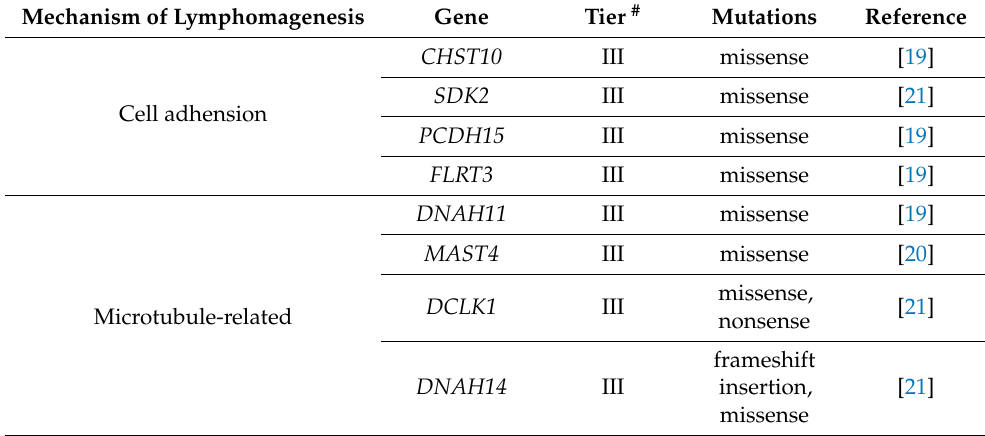
Table 1. Summary of mutated genes from five NGS studies in patients with ENKTCL [19–21,27,28]. Only mutated genes that were identified in ≥ 2 patient samples/cell lines in the reference studies are listed in the table. Tiers of gene mutations are classified according to guideline from Associ- ation of Molecular Pathology, American Society of Clinical Oncology, and College of American Pathologists [53]. Only DDX3X and TP53 mutations have been shown to have prognostic impact. Mechanism of Lymphomagenesis